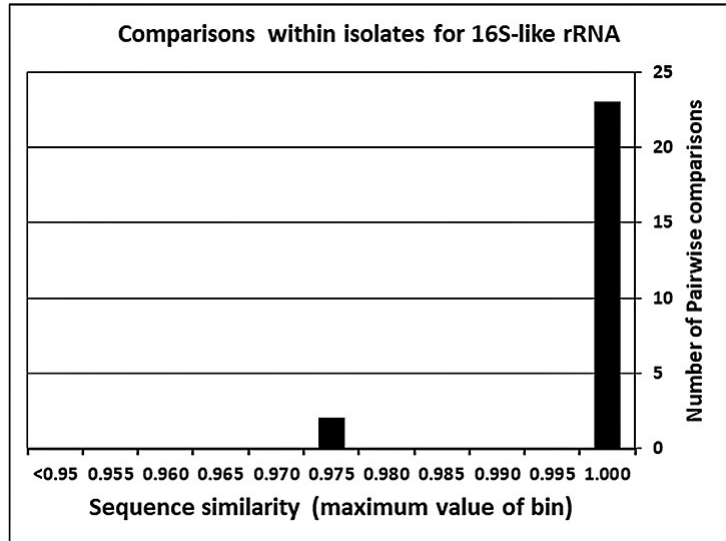
Figure 2. Pairwise sequence similarity between multiple independent sequences of the mitochon- drial 16S-like rRNA gene within an ATCC isolate. 16S-like rRNA gene within an ATCC